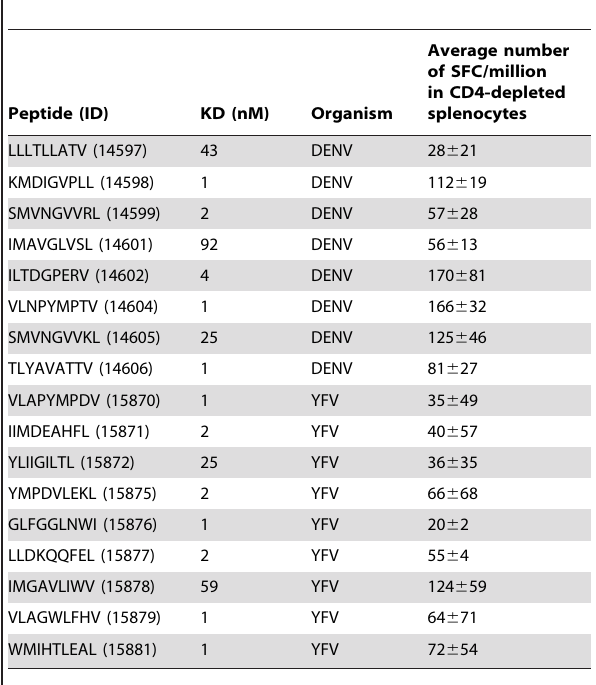
Table 3. ELISPOT results on peptide pool-immunized B*07:02 mice.